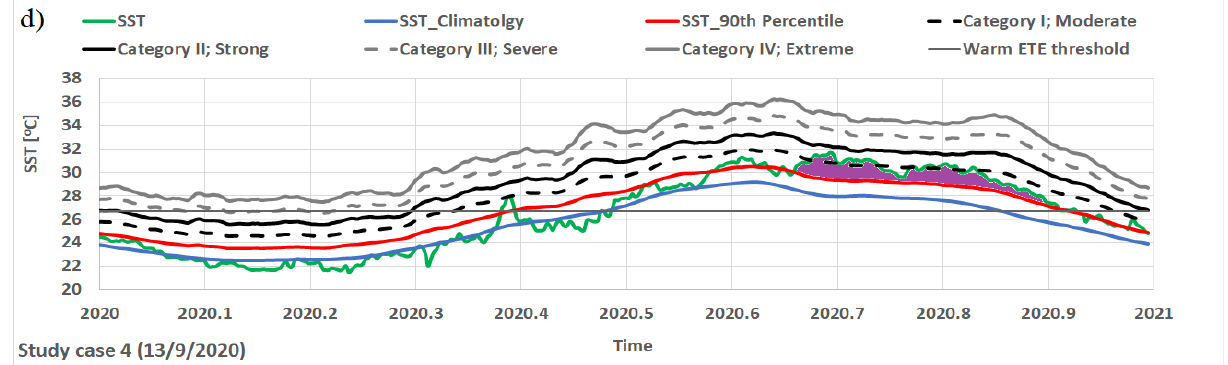
Figure 17. Representative of the MHW event (study case 4) showing the sea surface temperature ( a ), intensity [°C] of marine heat wave event ( b ) and category of that event ( c ) at the peak of the event and the time series during the event’s year ( d ), spatially averaged over an area around the maximum intensity grid, which is shown in bubbles.